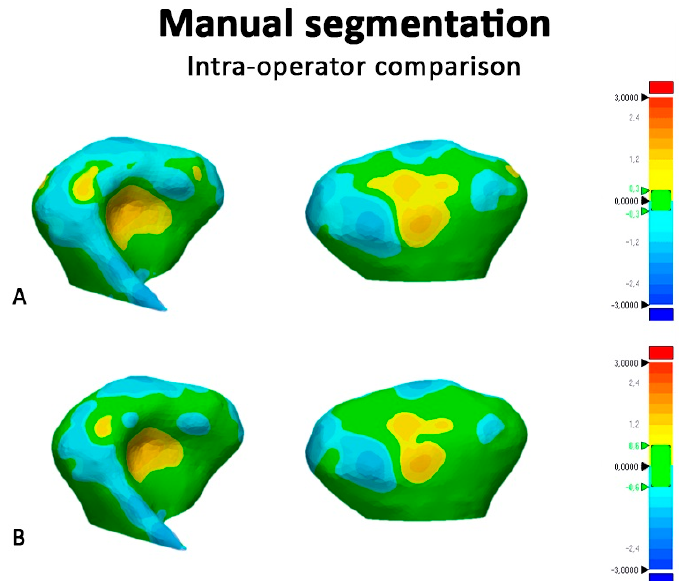
Figure 7. Surface-based deviation analysis between 3D condylar models obtained with manual segmentation performed respectively by two operators with di ff erent levels of expertise. The green of the color scale bars represents the range of tolerance. ( A ), Color map set to a range of tolerance of ± 0.3 mm Right side. ( B ), Color map set to a range of tolerance of ± 0.6 mm.